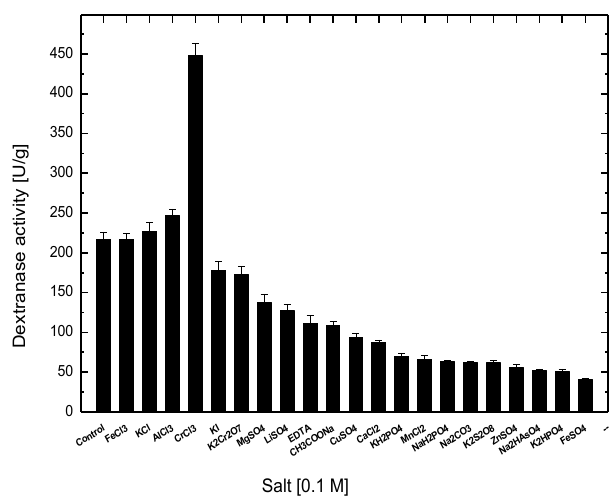
Figure 5. Effect of different salts on dextranase production from Bacillus subtilis NRC- B233b .